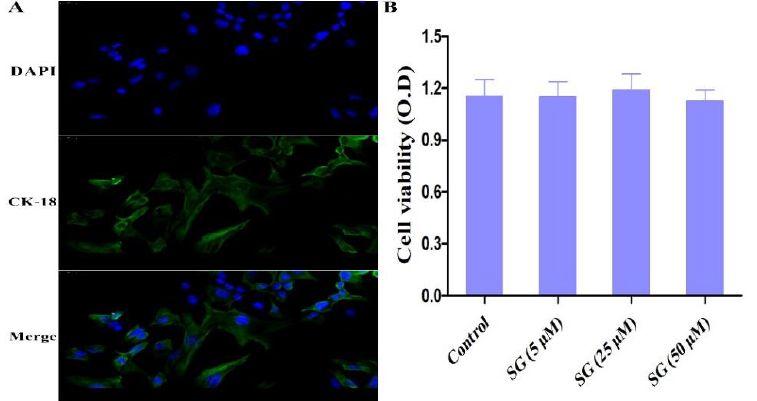
Figure 3. Cell viability and biological detection. ( A ) Cytokeratin-18 was used to identify the integrity of mMECs (scale bar: 20 µm). ( B ) The effect of SG on cell viability was detected by MTT assay. Data are presented as the means ± SEMs of three independent experiments.